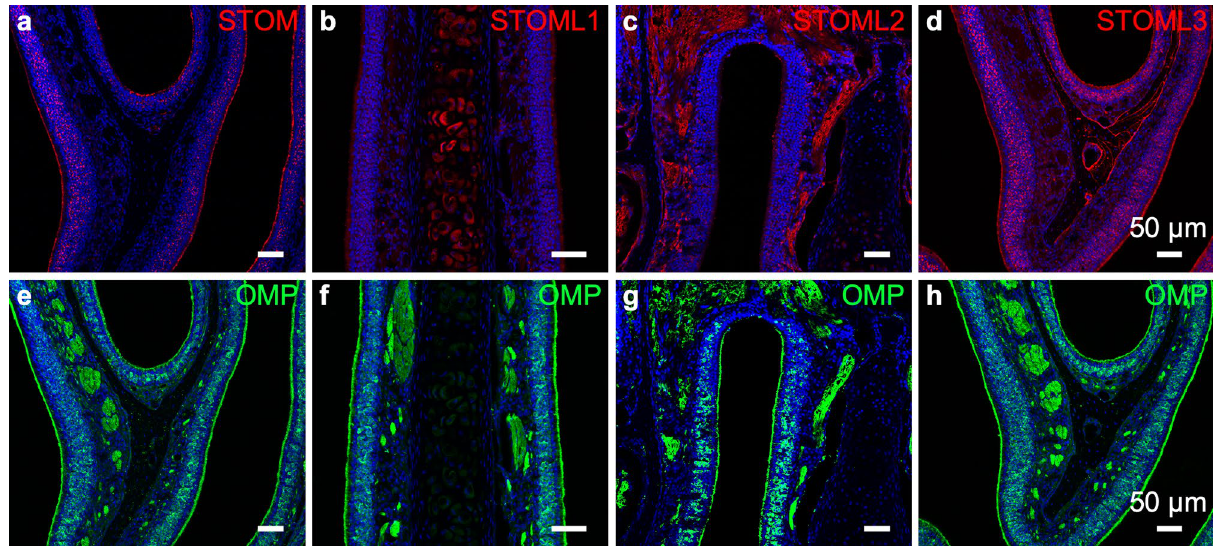
Figure 2. Stomatin-domain protein localization in olfactory areas of the nasal cavity. Confocal micrographs at low magnification of coronal sections of the OE of WT mice immuno-stained with antibodies (red) against STOM ( a ), STOML1 ( b ), STOML2 ( c ), and STOML3 ( d ). The same sections were double-stained with anti- OMP antibodies ( e – h , green). At low magnification, STOML2 is mainly visible around the axon bundles of the OSNs, while STOML1 is detected in the cartilage of the nasal septum. STOM and STOML3 predominantly localize in the apical part of the OE along the interface with the lumen of the nasal cavity. Nuclei were stained with DAPI